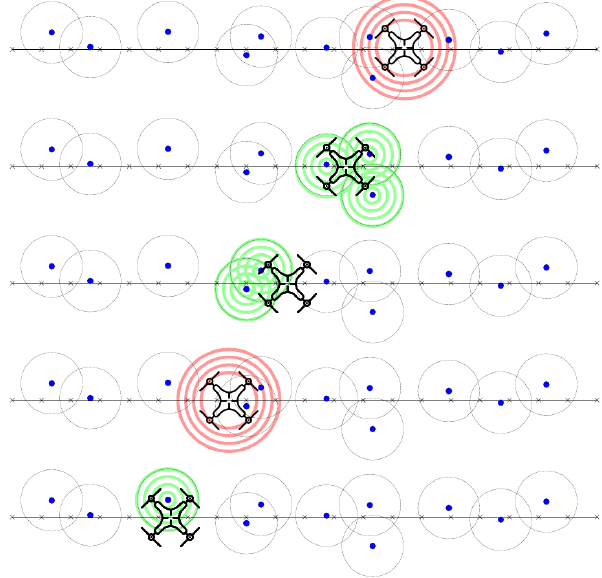
Figure 7. UAV Probe Flight for ground WSN nodes revealing. Algorithm 3 . UAV unicast message received from sensor node function (pseudo-code).